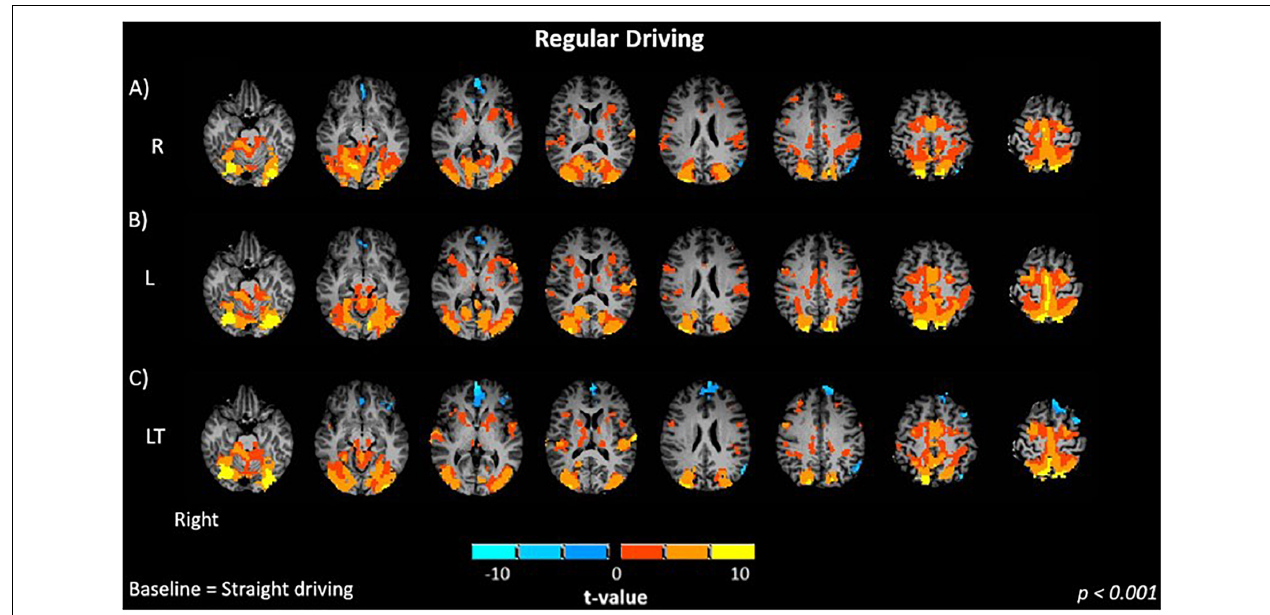
FIGURE 2 | Brain activations of participants when performing regular driving tasks: (A) R, right turns; (B) L, left turns; (C) LT, left turns with oncoming traffic. Activations are shown as t contrasts in comparison with straight driving, and are reported with a statistical significance threshold of p < 0.001. “Right” indicates the right cerebral